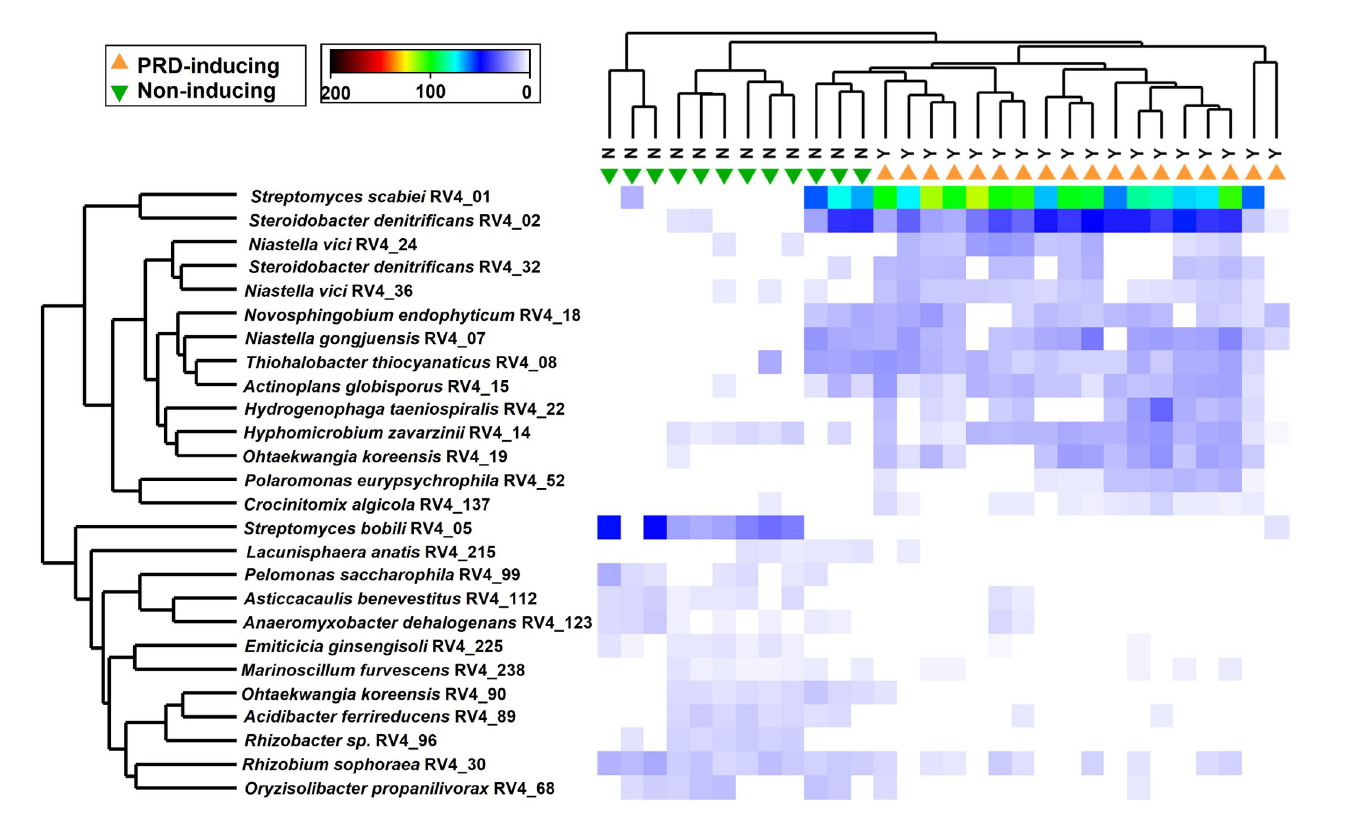
Fig 7. Heatmap and hierarchical clustering of the top-26 bacterial ASVs selected as important variables in the random forest classification model. The heatmap was coded according to square-root transformed abundances (depicted by color intensity) as a function of ASV (rows) and sample (columns). The 30 samples were from non- treated portions of 10 replant soils, with three replicate samples per soil. Hierarchical clustering was based on Bray-Curtis dissimilarities among ASV abundances (among- sample at top and among-ASVs at left). The abundances were CSS-normalized and square-root transformed before generation of Bray-Curtis dissimilarity matrices. ASV labels include: NCBI Blast hit, coding for tissue and primer set (e.g., “RV4” indicated root amplicon amplified by the V4 primers, “OOM2” indicated root oomycetes amplicon amplified by the ITS2 primers), and ASV number.